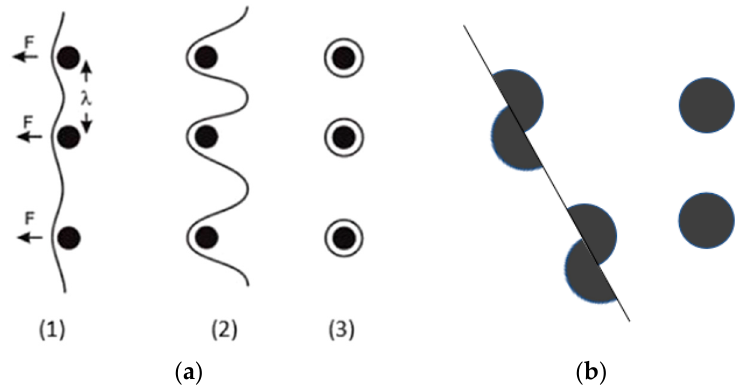
Figure 4. Schematic of ( a ) Orowan looping, ( b ) shearing the particles after the interaction by dislocations [100].